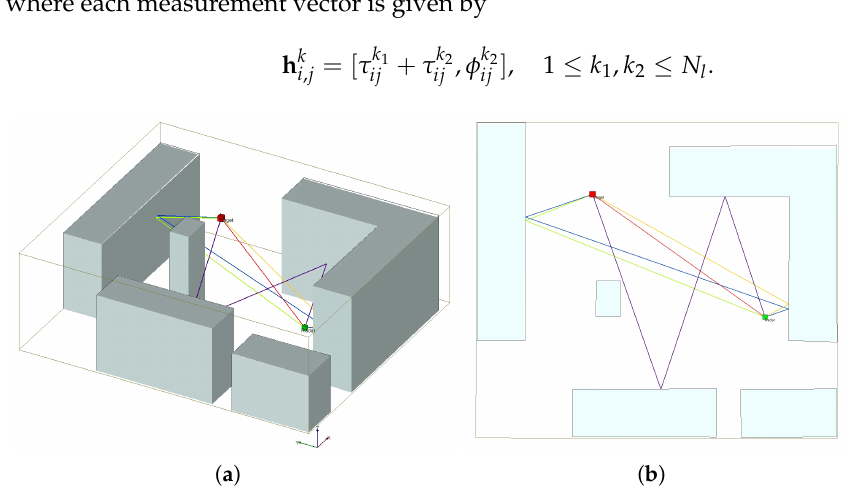
Figure 1. Ray-tracing simulation examples: ( a ) 3D ray-tracing; ( b ) 2D